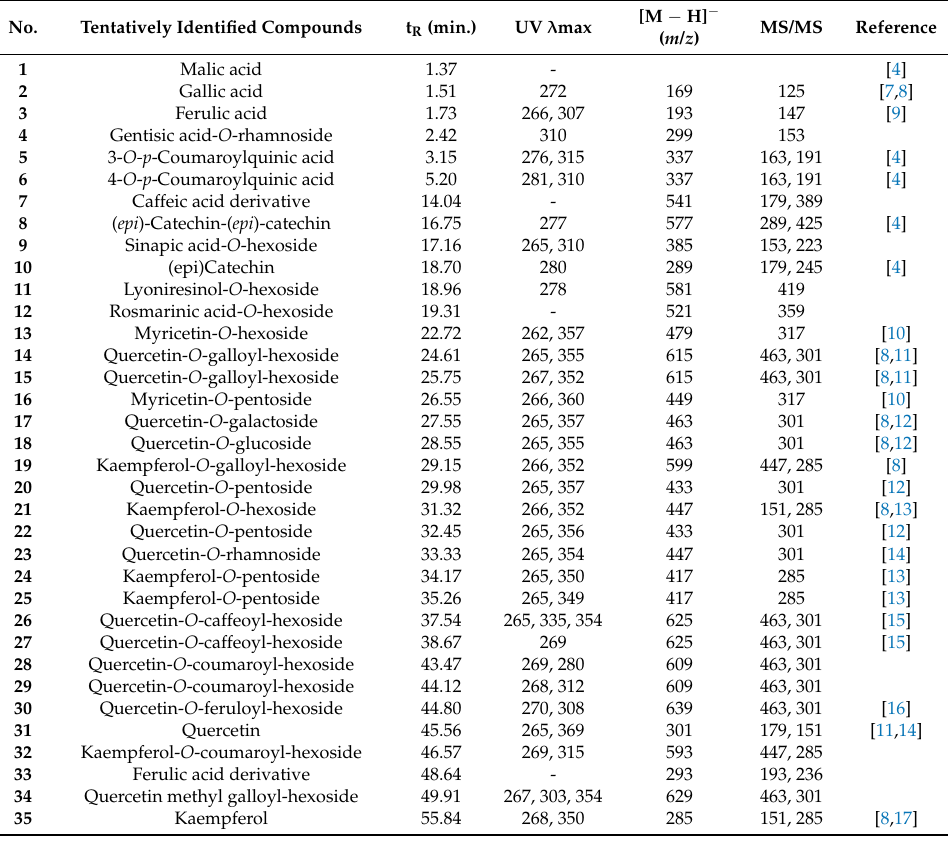
Table 1. Chemical constituents of the methanol leaf extract of A.